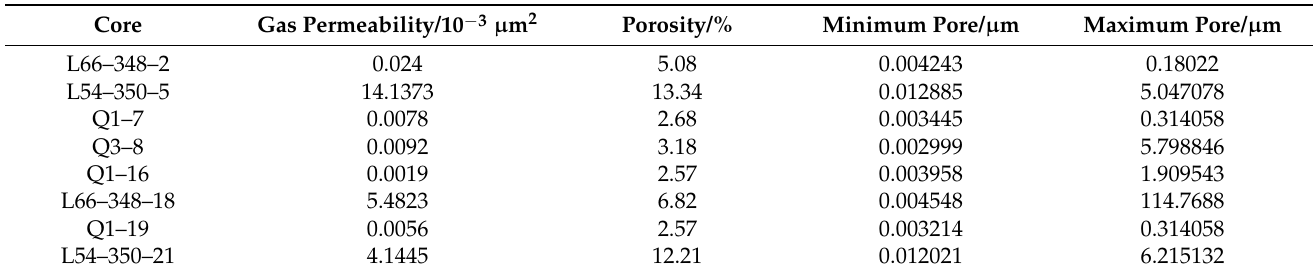
Table 8. Pore threshold analysis.